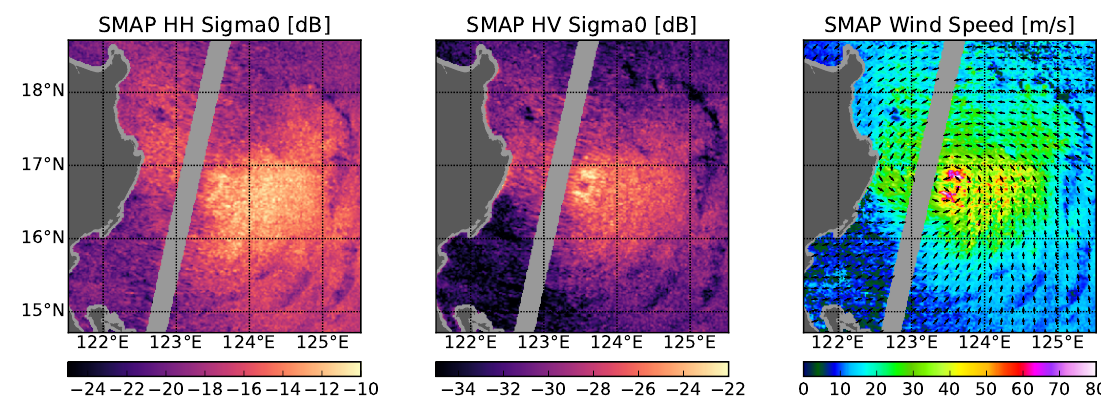
( a ) Super Typhoon Noul on May 9th 2200 UTC; JTWC best track indicates 71 m/s